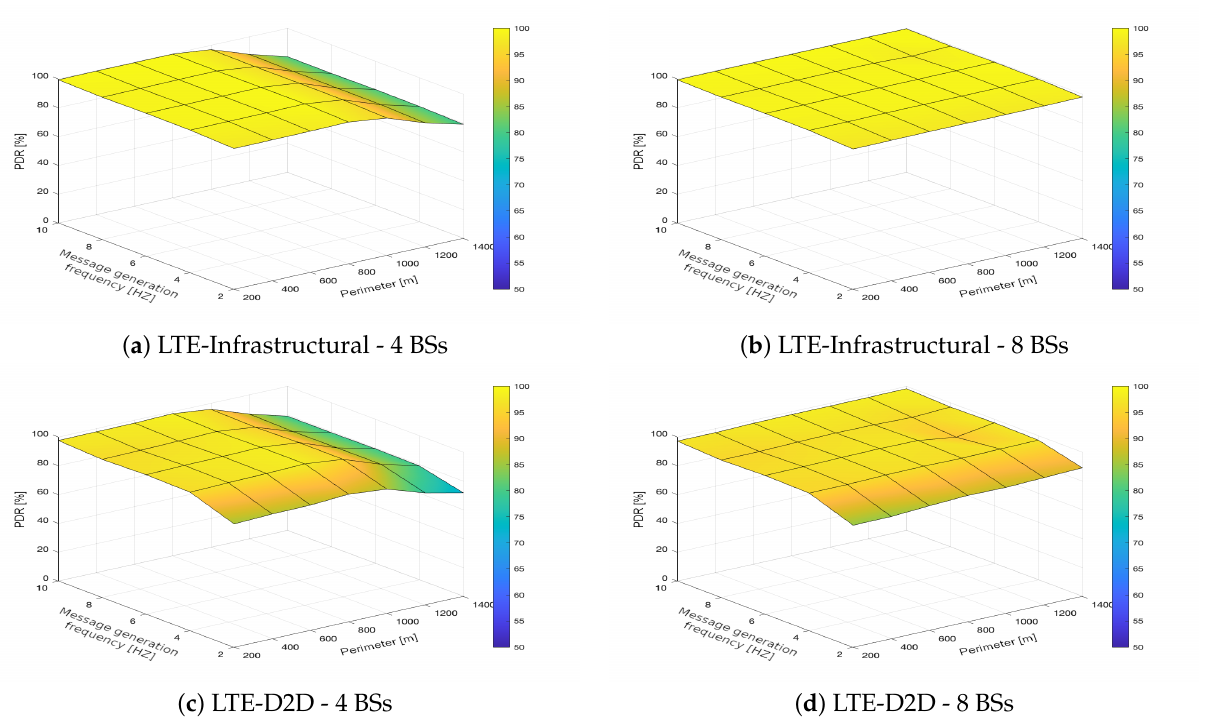
Figure 14. PDR simulated for the both modes of the 4G-based C-V2X technology, both infrastructure density deployments and traffic intensity of 250 vehicles per